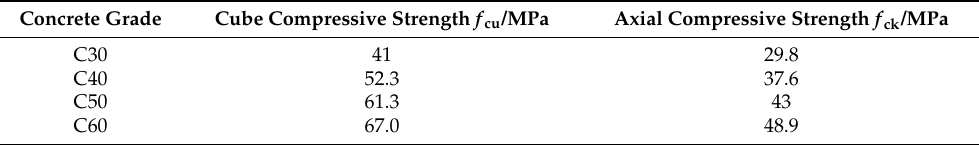
Table 3. Compressive strength and axial compressive strength of the